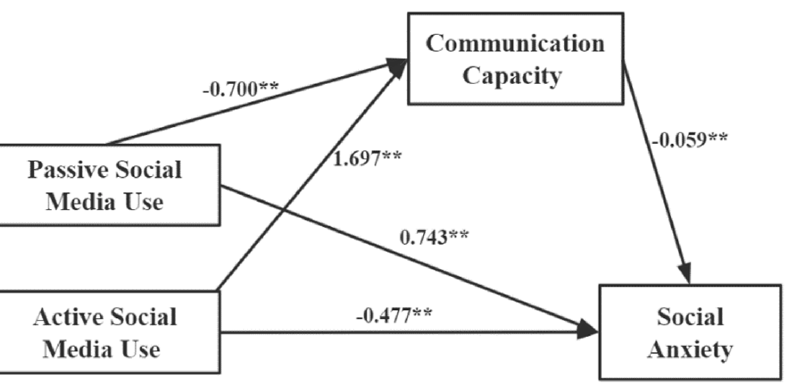
Figure 2. Model of the mediating effect of communication capacity on the association between social media use and social anxiety. Note: ** p < 0.01. The normalized path coefficient is represented by the number on the solid line. There are two mediation paths in the diagram: 1. Passive social media use → Communication capacity → Social anxiety 2. Active social media use → Communication capacity → Social anxiety. Table 3. Structural equation model fit index.